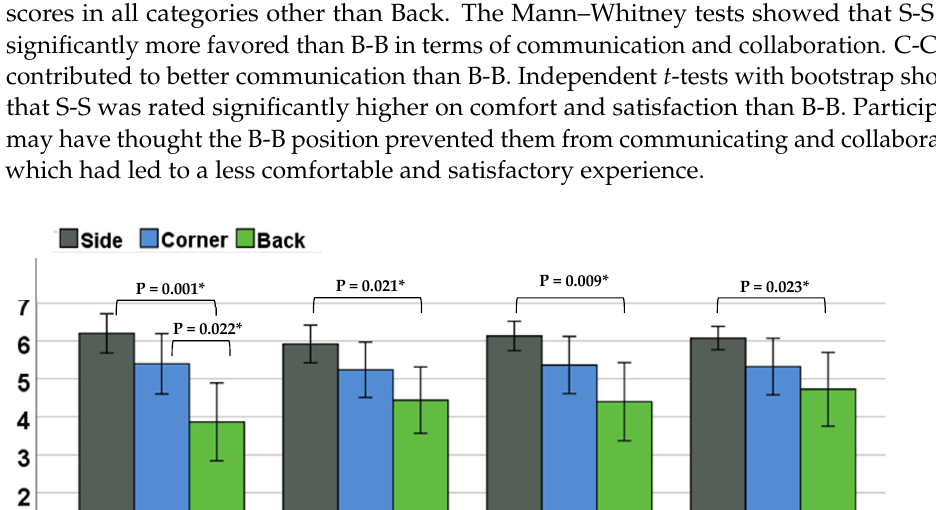
Figure 9. Mean ratings for the communication, collaboration, comfort, and satisfaction categories of the collaboration questionnaire. Error bar indicates ±2 standard errors.